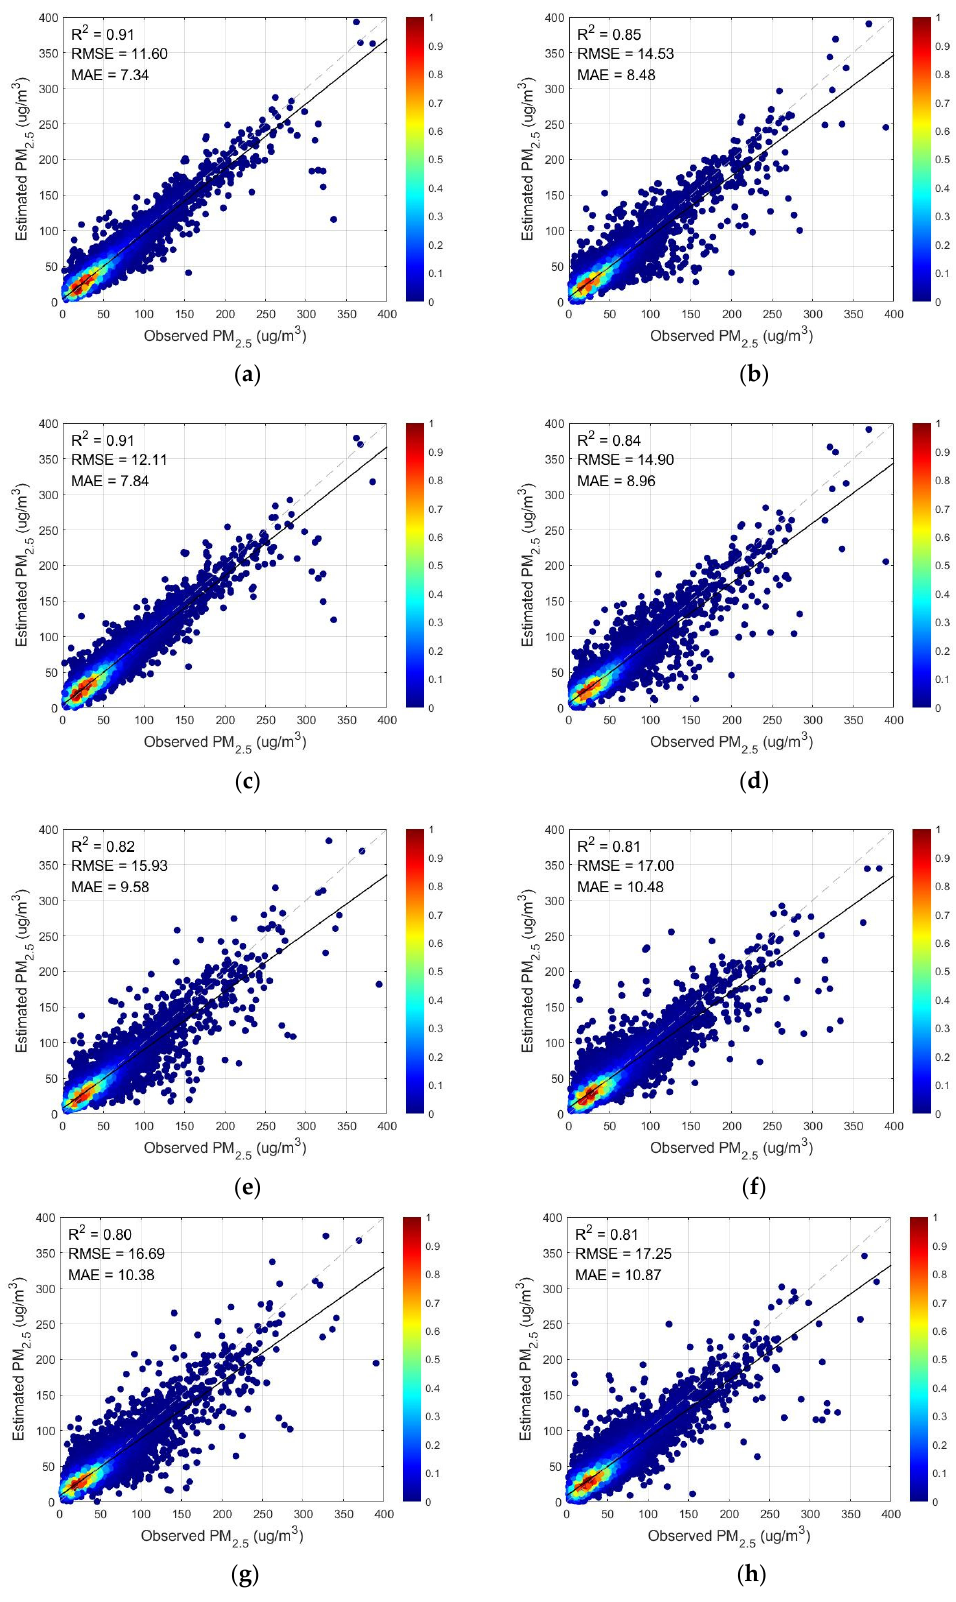
Figure 6. Scatter plots of the model prediction results with different input variables versus the actual PM 2.5 values. TOAR-based on the left and AOD-based on the right. Wavelet decomposition is added to ( a , b , e , f ) and not added to ( c , d , g , h ); meteorological elements are added to ( a – d ) and not added to ( e – h ). The dashed line is the 1:1 line, and the solid line is the fitted line. Table 4. Model design and performance.